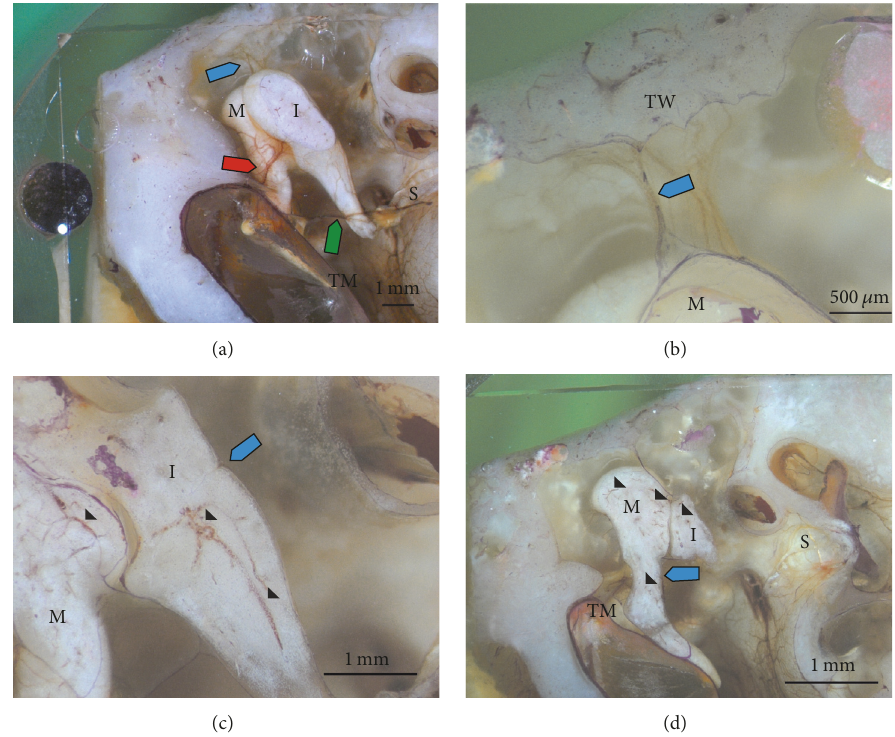
Figure 2: Reflected light microscopic images of the grinding surface after surface staining with modified staining according to Mann- Dominici. (a) Inside the tympanic cavity the stained tympanic membrane (TM) and incus (I), as well the deeper lying malleus (M) and stapes (S), can be seen. The blood supply is guaranteed by a branch of the anterior tympanic artery inside the plication of the superior malleolar ligament (blue arrow) and inside the anterior malleolar plication with its dividing point to the malleus and incus (red arrow). Additionally, the posterior tympanic artery runs over the incudostapedial joint and emits a branch to the malleus (green arrow). In (b) the superior branch of the anterior tympanic artery follows the plication of the superior tympanic ligament from the tympanic wall (TW) to the head of the malleus (blue arrow). In (c) the entrance of a branch of the posterior tympanic artery emitting to the incus on its medial side through a nutrient foramen is depicted (blue arrow) as well as the blood vessel system inside the malleus and incus (arrowhead). Only the cartilage area inside the incus (asterisk) contains no vessels. In (d) the entrance of a branch of the posterior tympanic artery through a nutrient foramen on the medial side of the malleus can be seen (blue arrow) as well as the blood vessel system inside the malleus and incus (arrowhead). Grinding surfaces after removing (a) 6.106 mm, (b) 7.460 mm, (c) 7.360 mm, and (d) 8.001 mm of the total sample,